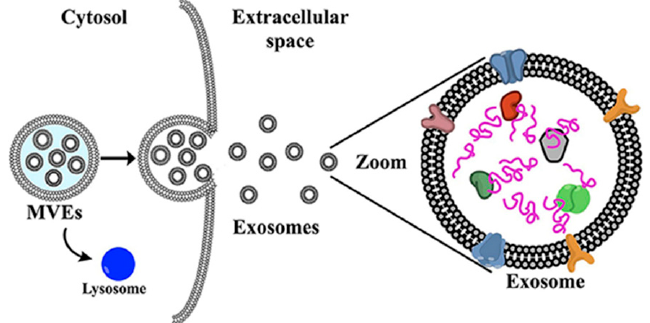
Figure 4. Exosome origin: Exosomes derive from the secretion of multivesicular endosome and can be purified and used for drug delivery purposes. Figure reprinted from de la Torre Gomez et al. [212].